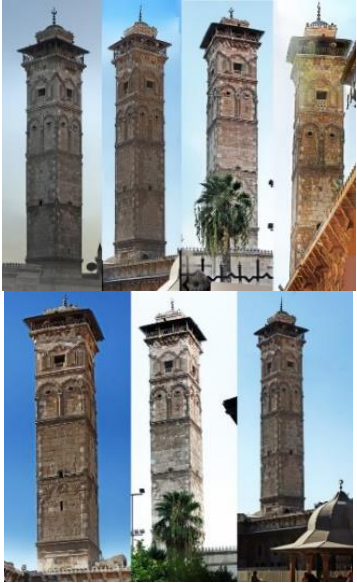
Figure 14: Some of the 22 spherical panoramas shot in 2010, used for the 3D reconstruction of the